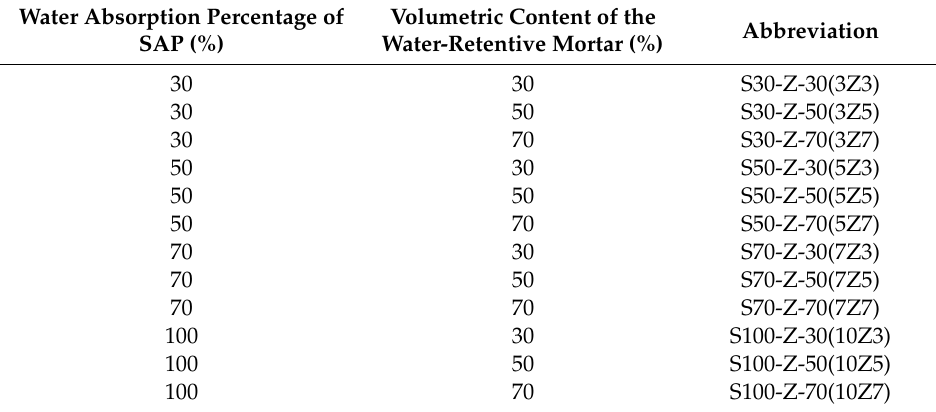
Table 10. The number of SAP mortar